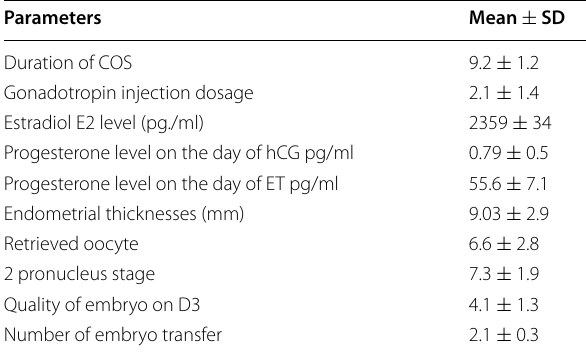
Table 3 The pharmacological doses, hormonal levels,